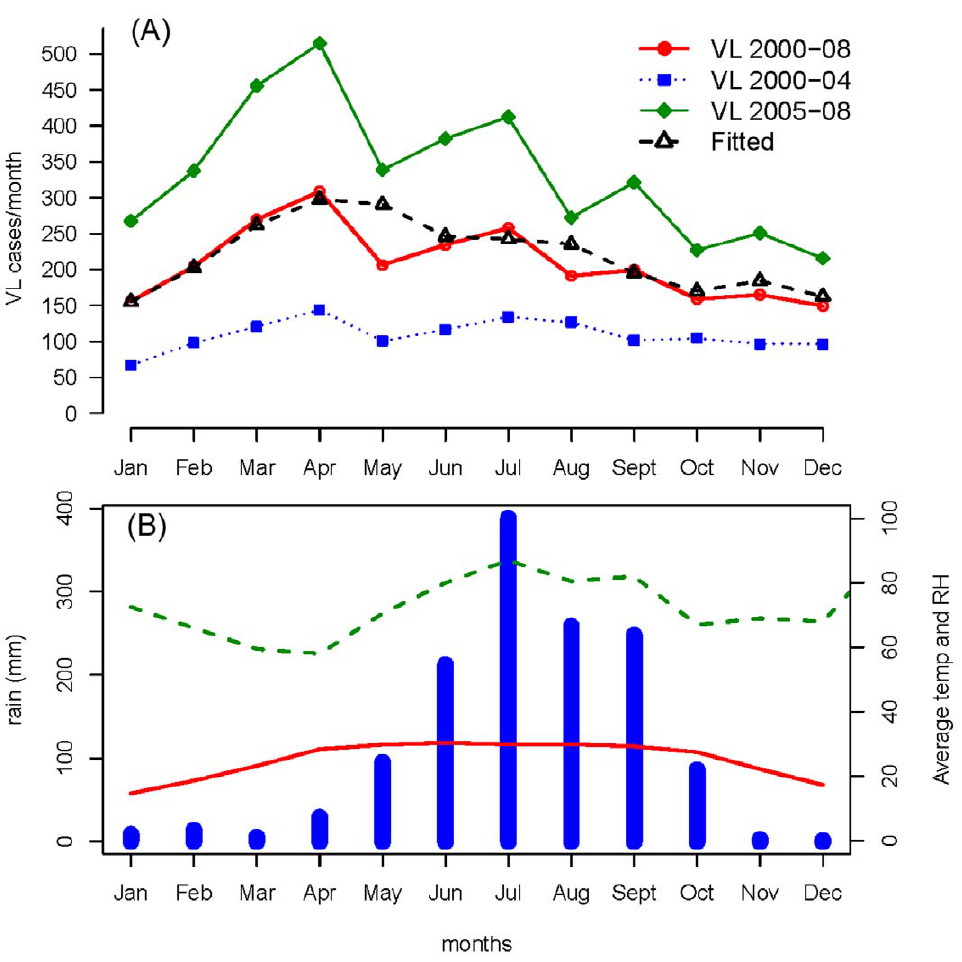
Figure 3. Seasonality of VL cases in the two phases (2000–04 and 2005–08) identified during the study period. (A) The observed average number of monthly Visceral Leishmaniasis (VL) cases in Muzaffarpur district: from 2000 to 2008 (solid red line), 2000 to 2004 (dotted blue line) and 2005 to 2008 (green line). Predicted average of monthly VL cases from 2000 to 2008 (estimated from the negative binomial model) plotted as black dotted line. (B) Monthly average rainfall in mm (blue histogram), temperature (temp) in u C (red line) and relative humidity (RH) in % (dashed green line).